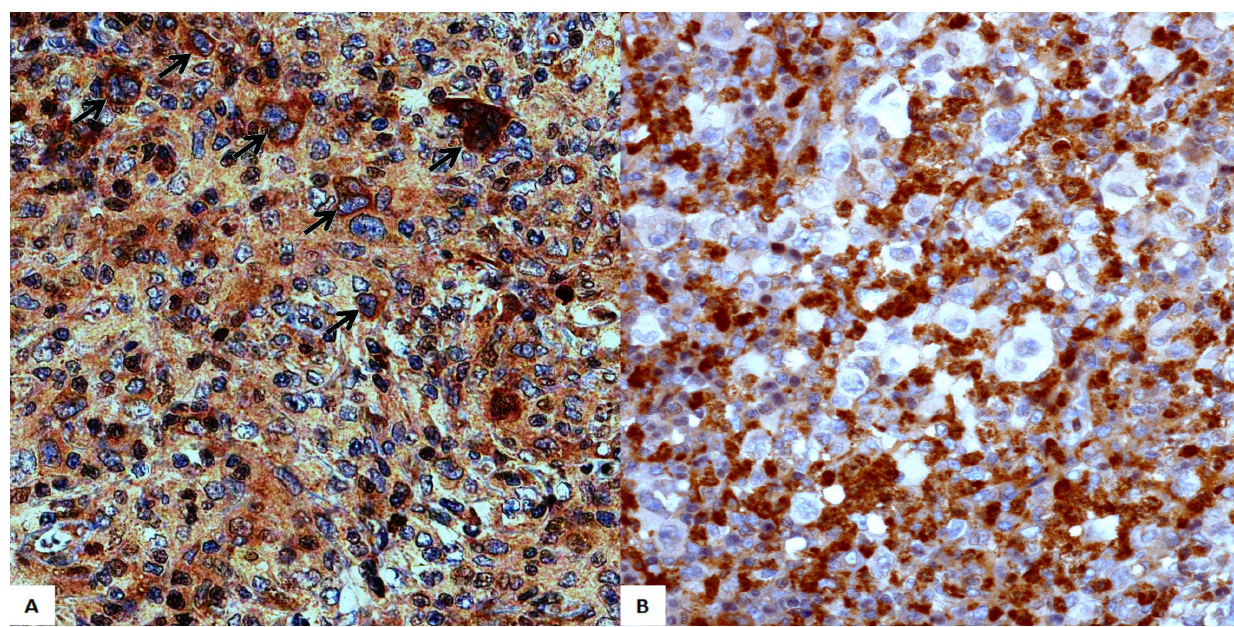
Figure 1. MMP9 expression in classical Hodgkin lymphoma (200x). (A) Cytoplasmic expression of MMP9 by Hodgkin-Reed-Sternberg cells (arrows). Variable staining is also observed in cells of the reactive background. (B) A case with positive cells in the reactive background, but no expression of MMP9 in Hodgkin-Reed-Sternberg cells.